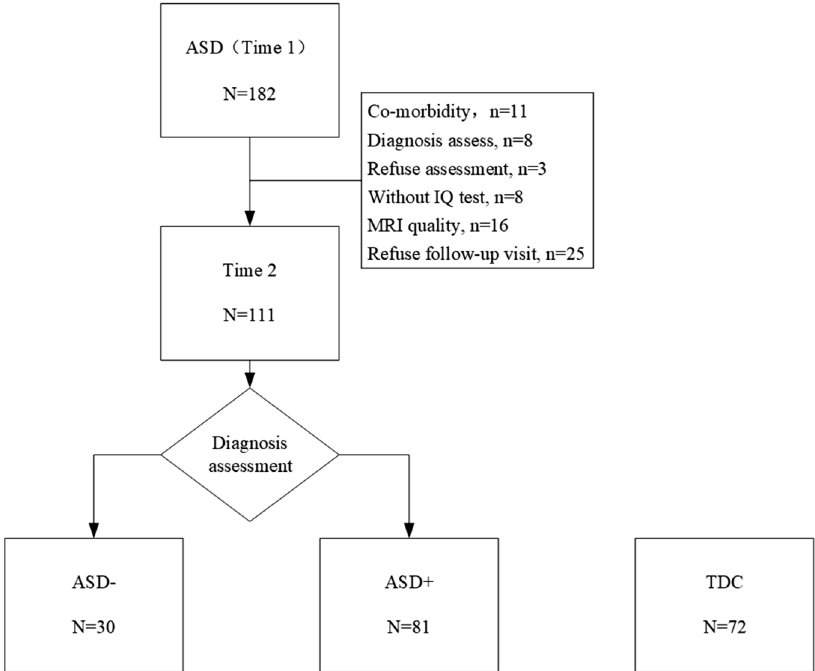
Figure 1. Study flowchart. ASD− ASD with optimal outcome, ASD+ ASD with persistent symptoms, TDC typically developing